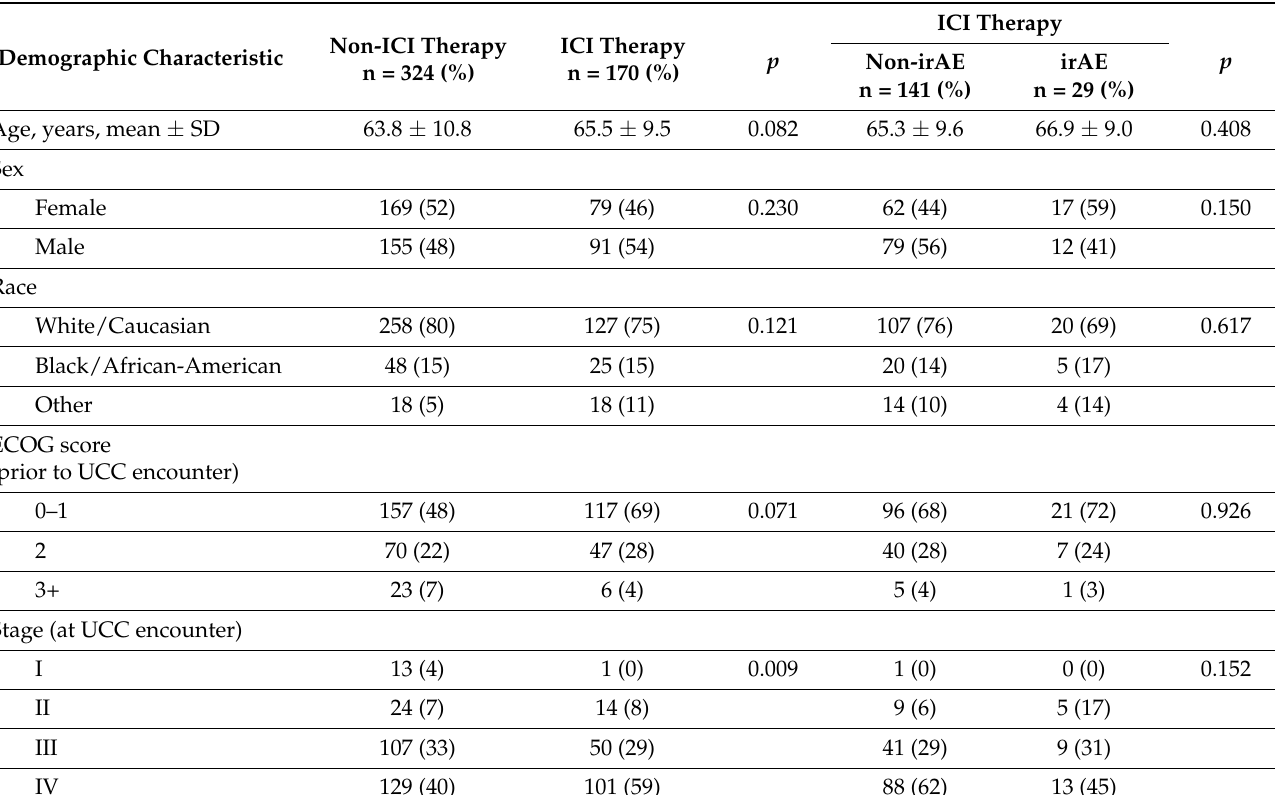
Table 1. Demographic data for urgent care clinic patient encounters from